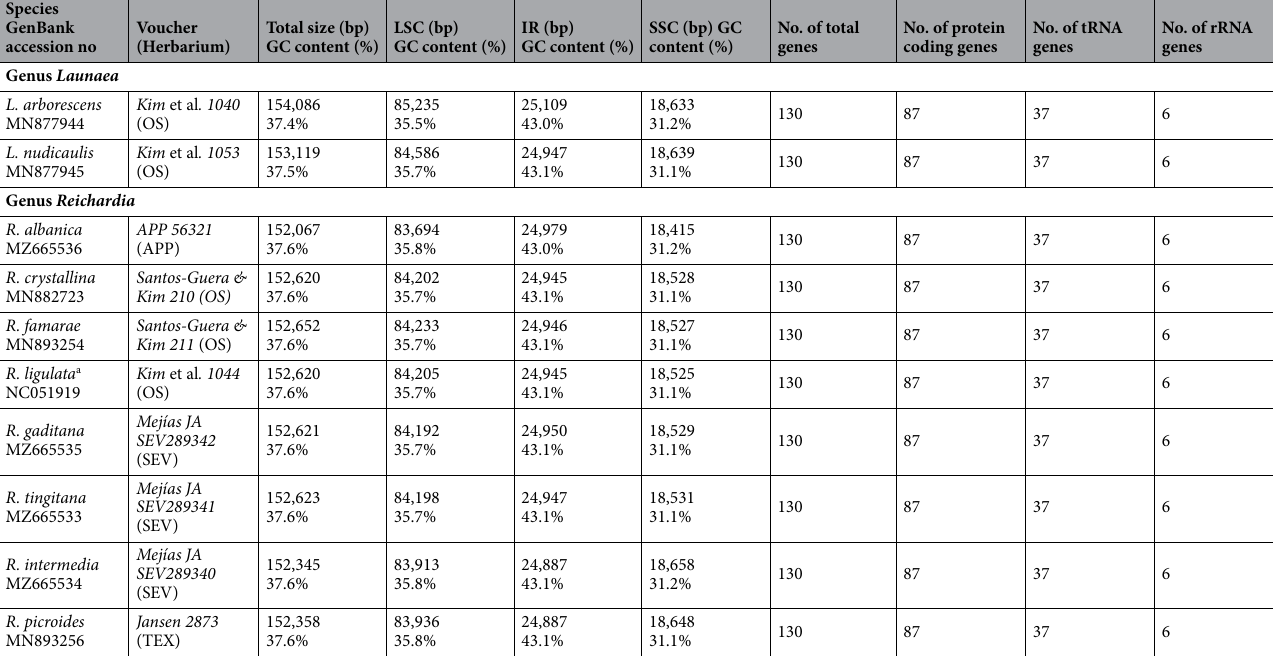
Table 1. Summary of the genomic characteristics of two Launaea and eight Reichardia chloroplast genomes used for comparative genomic analyses in this study. Herbarium code: APP: Parco Nazionale del Gran Sacco remaining nine cp genomes were sequenced for this